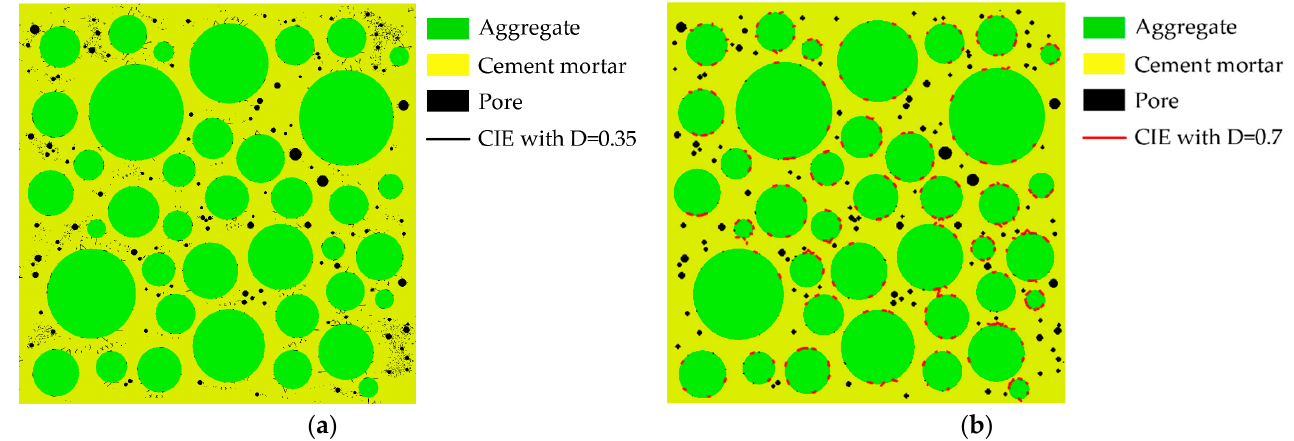
Figure 12. The distribution of CIEs with D = 0.35 and D = 0.7 when σ / σ max ≈ 0.7 in the 1-1-S specimen. ( a ) D = 0.35; ( b ) D = 0.7.